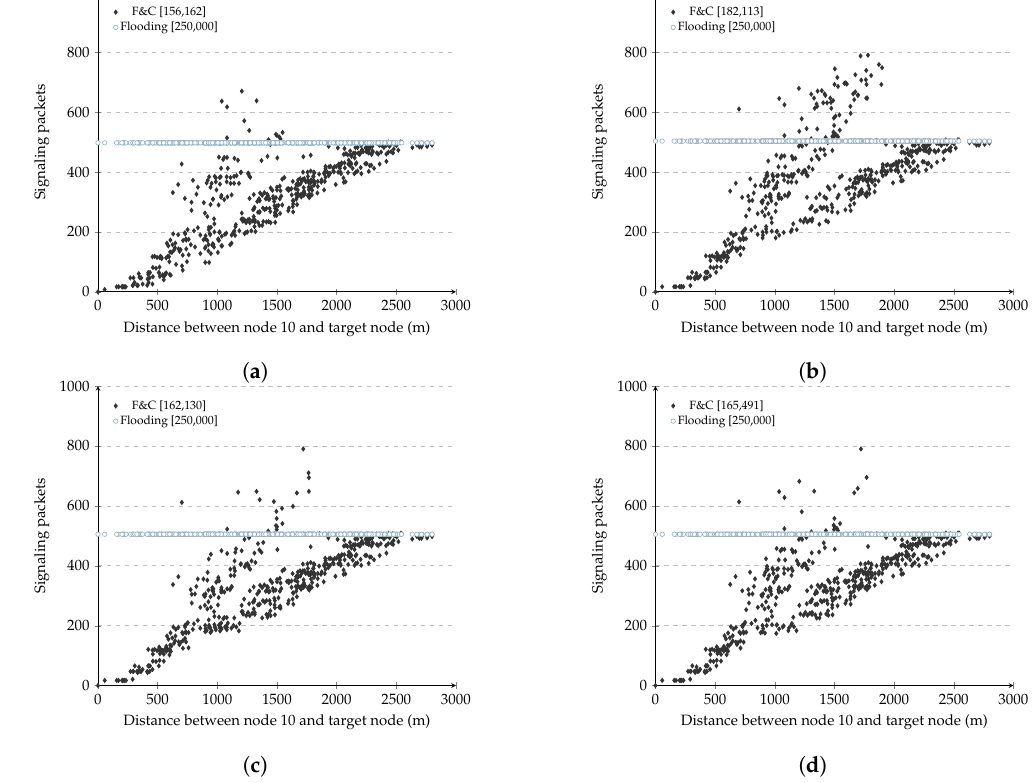
Figure 10. F&C: Signaling packets for different repeal-flooding boundary values. ( a ) Using optmized repeal-flooding boundary; ( b ) After 2 resource discovery searches; ( c ) After 5 resource discovery searches; ( d ) After 10 resource discovery searches.